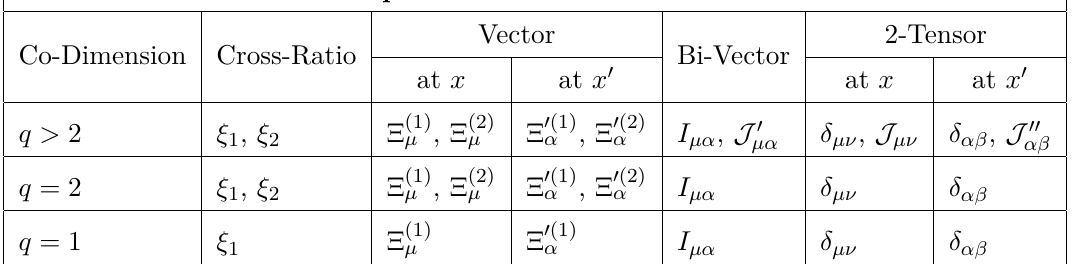
Table 1 . List of independent tensor structures used to construct two-point correlation function between any two bulk primaries with arbitrary spin. The definition of the cross-ratios, vectors, bi-vectors and rank-2 tensors can be found in (2.2), (2.4), (2.6) and (2.8) respectively.